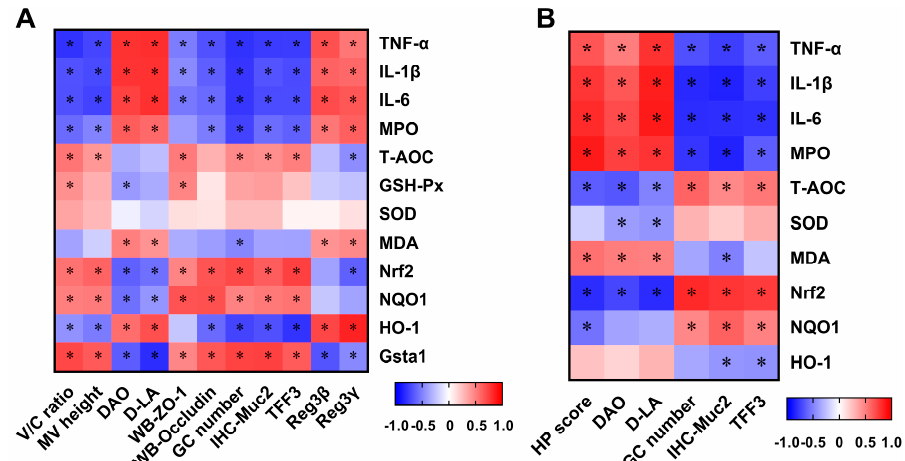
Figure 9. Correlations between intestinal damage biomarkers and indices related to inflammation and oxidative stress in the jejunum ( A ) and colon ( B ) of mice. Cells marked with an asterisk show signifi- cance following Spearman correlation for multiple comparisons ( p < 0.05). V/C, villus height/crypt depth; MV, microvillus; DAO, diamine oxidase; D-LA, D-lactate; ZO-1, Zonula occludens 1; GC, goblet cells; Muc2, mucin-2; TFF3, trefoil factor family 3; Reg3, regenerating gene type III; TNF- α , tumor necrosis factor- α ; IL-1 β , interleukin-1 β ; IL-6, interleukin-6; MPO, myeloperoxidase; T-AOC, total antioxidant capacity; GSH-Px, glutathione peroxidase; SOD, superoxide dismutase; MDA, malonaldehyde; Nrf2, nuclear factor E2-related factor 2; NQO1, NADPH quinone oxidoreductase 1; HO-1, heme oxygenase-1; and Gsta1, glutathione S-transferase class alpha